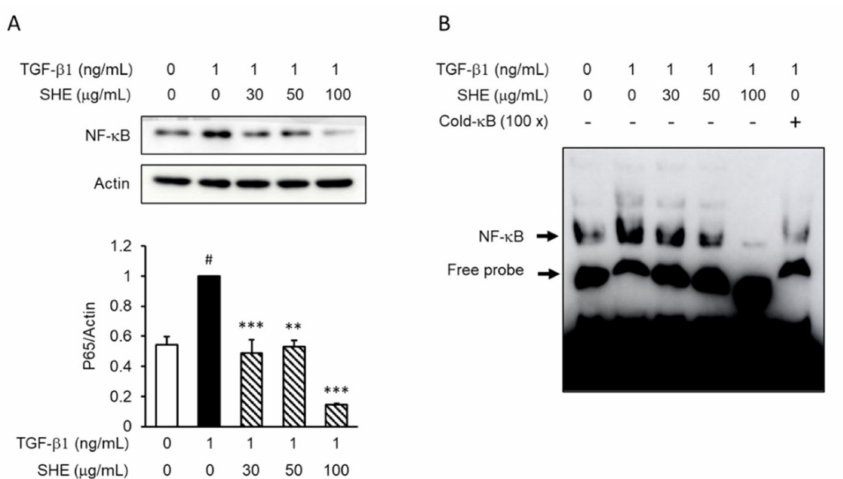
Figure 5. Effect of SHE on the activation of nuclear factor kappa B (NF- κ B) in TGF- β 1-induced NPDFs. The NPDFs were treated with SHE (30, 50, and 100 µ g/mL) for 1 h and then stimulated with TGF- β 1 for 1 h. ( A ) The level of nuclear translocation of NF- κ B was analyzed using western blot with nuclei protein; ( B ) The binding activity of NF- κ B was evaluated using electrophoretic mobility shift assay (EMSA). Each bar represents the mean ± SEM ( n = 3) from three independent experiments. # p < 0.05 vs. control group (no treatment group); ** p < 0.01 and *** p < 0.001 vs. TGF- β 1-stimulated group. Cold- κ B, unlabeled NF- κ B